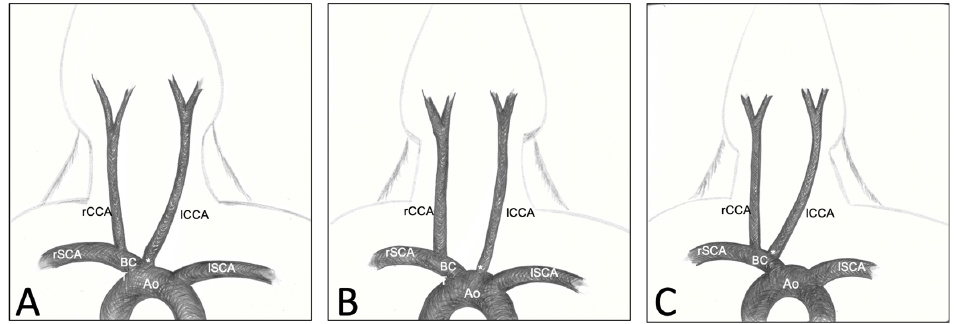
Figure 1. Classification of the three CCAs’ origin variations. Type 1: lCCA originating from the bifurcation of the aortic arch and the BCT ( A ); Type 2: lCCA originating from the aortic arch ( B ); Type 3: lCCA originating from the BCT, next to the rCCA ( C ).